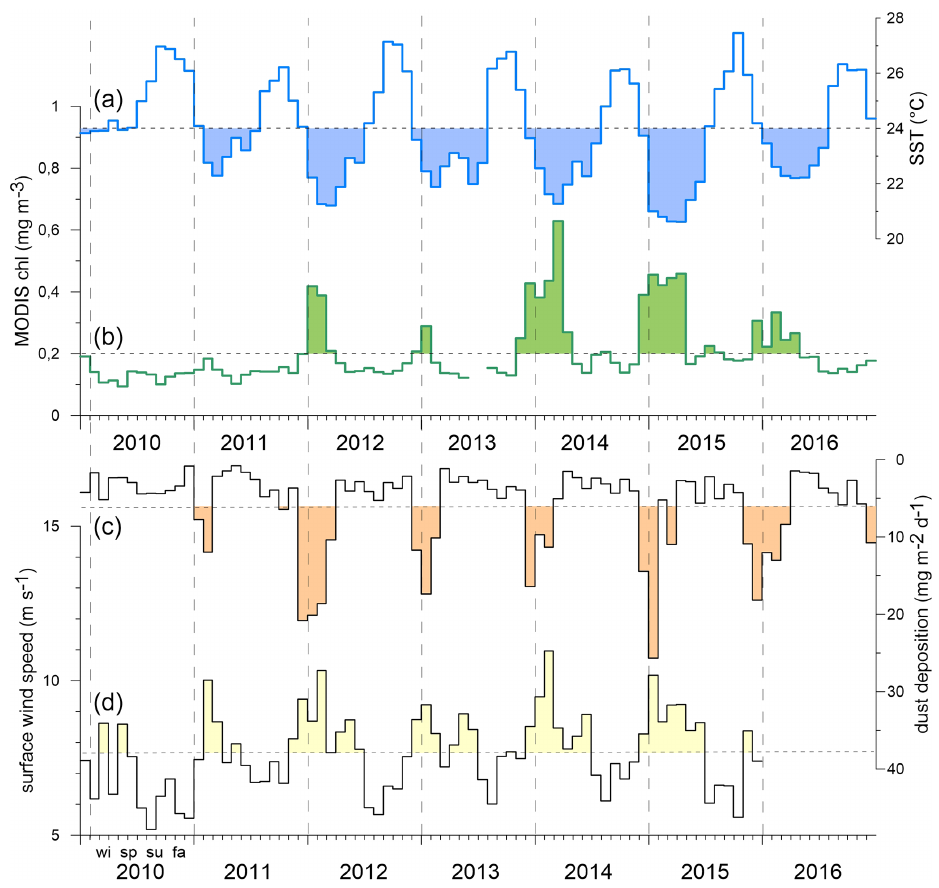
Figure 2. Monthly SSTs (a) , chlorophyll (b) , modeled (MERRA) dry dust deposition (c) and surface wind speed (d) recorded in the study box northeast (17 ◦ 30 (cid:48) –18 ◦ 30 (cid:48) N and 23–24 ◦ W) of CVOO between 2010 and 2016 (satellite-derived, from Giovanni, https: //giovanni.gsfc.nasa.gov/giovanni/#service=TmAvMp&starttime=&endtime=, last access: 6 August 2020). Note that during the extreme ACME during winter 2010, chlorophyll, surface wind and dust deposition were all low, combined with relatively high SSTs. Thereafter, surface biomass, winds and dust increased during winter and early spring. Horizontal dashed lines indicate mean values; peaks above or below are marked as filled bars. Vertical dashed lines mark years; wi, sp, su and fa indicate the seasons (winter, spring, summer,